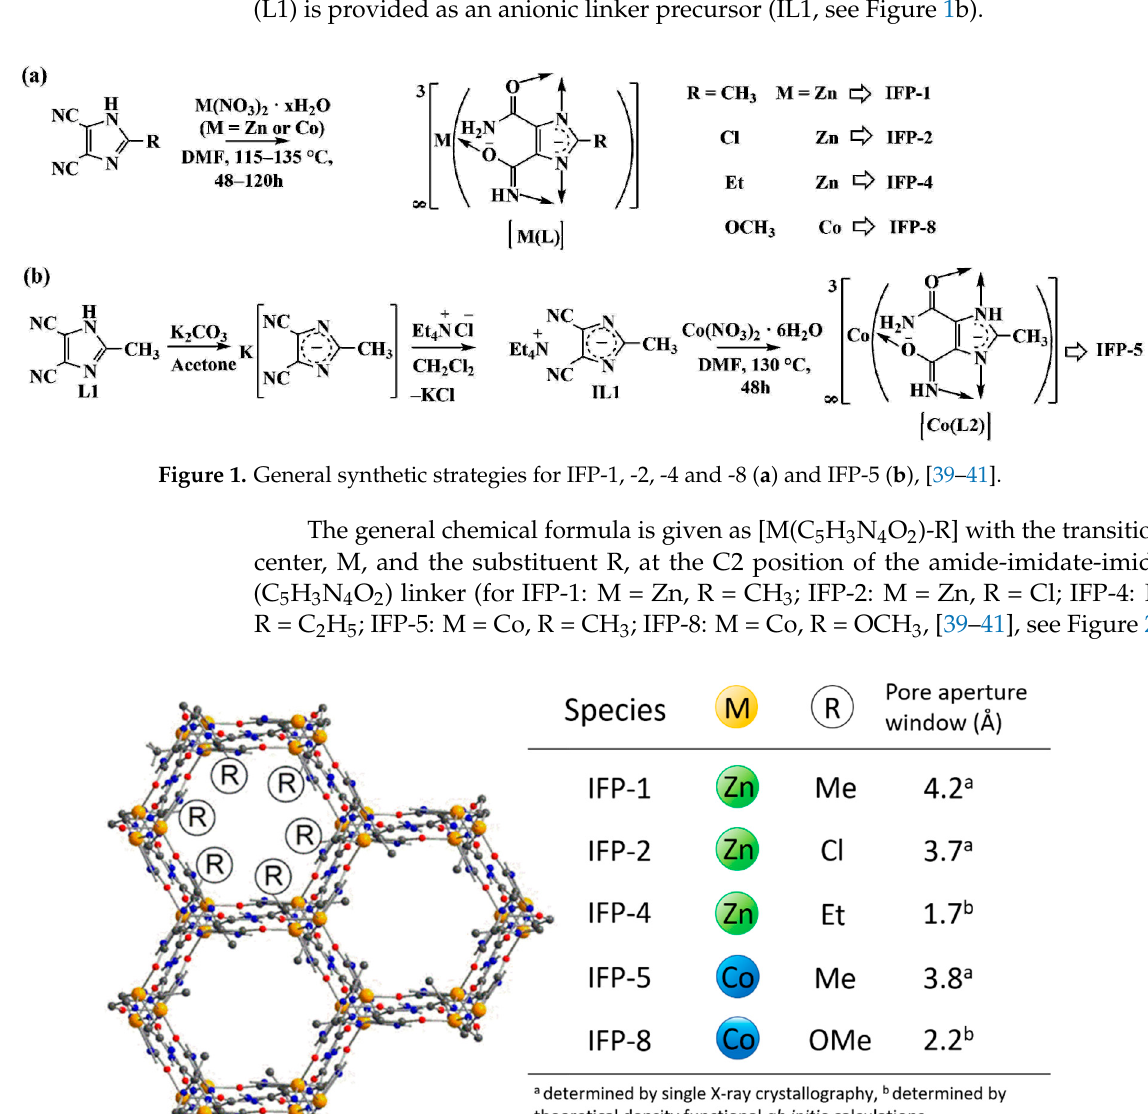
Figure 2. Schematic presentation of the 1D hexagonal channels of IFPs ( left ) (metal center: yellow, nitrogen: blue, oxygen: red, carbon: grey) with an overview of the corresponding pore aperture windows derived from crystallographic data and density functional ab initio calculations ( right ).